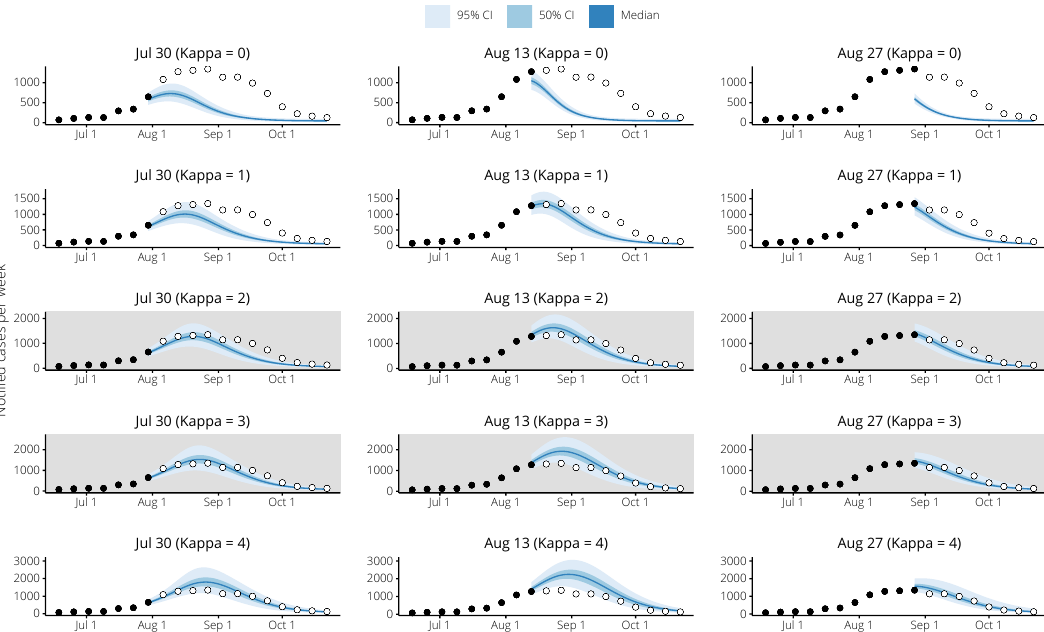
Figure 8. Example 2017 forecasts for Brisbane, Queensland, for various values of κ . Each column show forecasts generated for the same date, and each row shows forecasts generated using the same value of κ . Black points indicate reported case counts in weeks up to the time of the forecast, and hollow points indicate reported case counts in future weeks. The optimal values of κ for the Brisbane forecasting targets were 2–3 (shown with grey backgrounds), and this is supported by a visual inspection of the forecasts for each of the forecasting